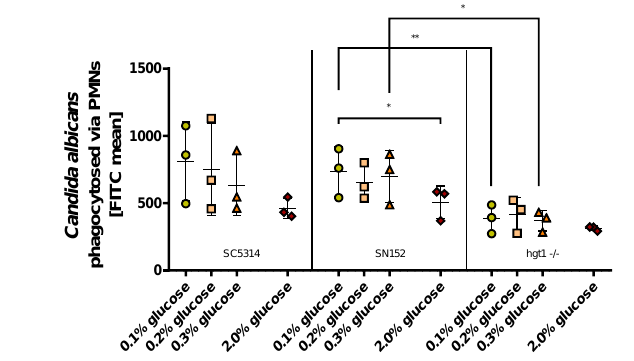
0.1% glucose ( − 19.44, 95% CI ( − 29.87, − 9.019), p = 0.0015), 0.2% glucose ( − 23.62, 95% CI ( − 34.05, − 13.2), p = 0.0004), and 0.3% glucose ( − 24.4, 95% CI ( − 34.82, − 13.98), p = 0.0003; Figure 2A right panel). Like SN152, the HGT1 knockout mutant (hgt1-/-) did not show any significant difference for the amount of yeast cells phagocytosed by PMNs when incubated at physiological glucose concentrations (Figure 2B right panel). In contrast to SN152, no significant difference could be shown in FITC mean between physiological glucose concentrations and the yeast cells incubated in 2% glucose (Figure 2B right panel). However, comparing the FITC mean of hgt1-/- to SN152, fewer hgt1-/- cells were phagocytosed at all